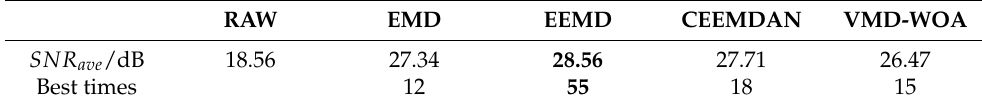
Table 5. Denoising performance of different algorithms for low SNR m signals. RAW